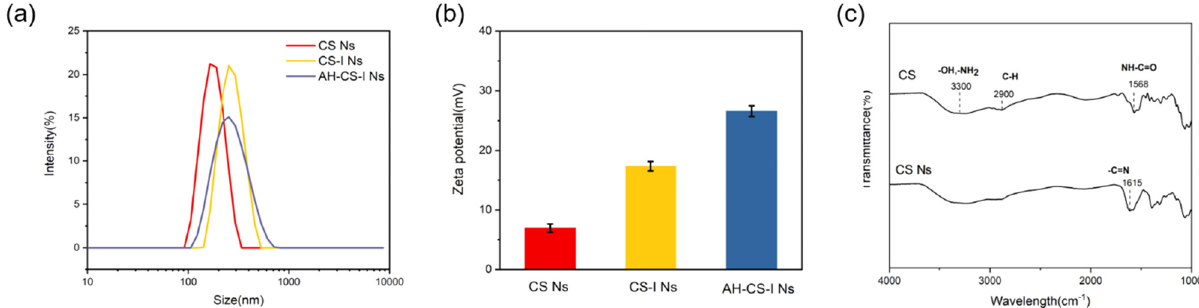
Figure 3: Characterization of obtained nanospheres. Size distribution ( a ) and zeta potential ( b ) of CS Ns, CS - I Ns, and AH - CS - I Ns. ( c ) FTIR spectra of CS and CS